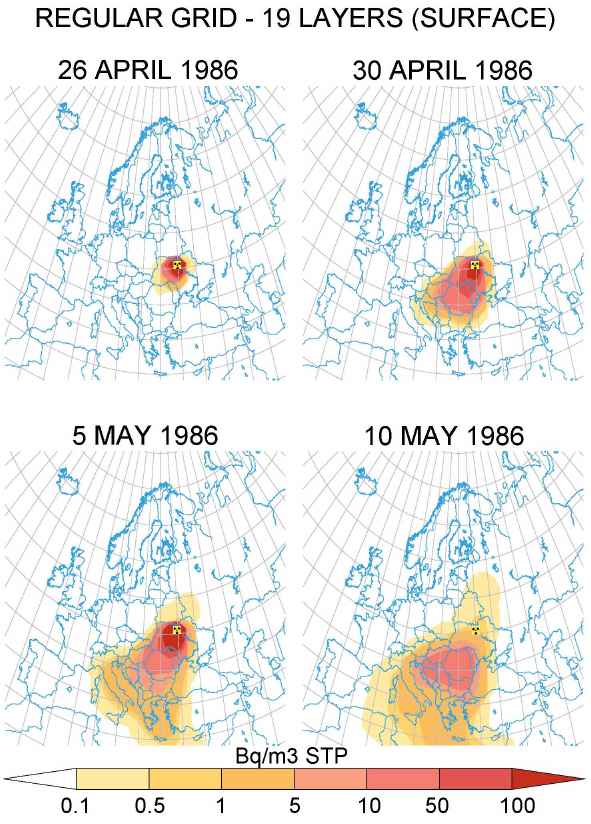
Fig. 2. Daily mean surface 137 Cs activity concentrations (in Bqm − 3 STP) from the Chernobyl accident. Model with regular grid and 19 vertical levels assuming surface emissions